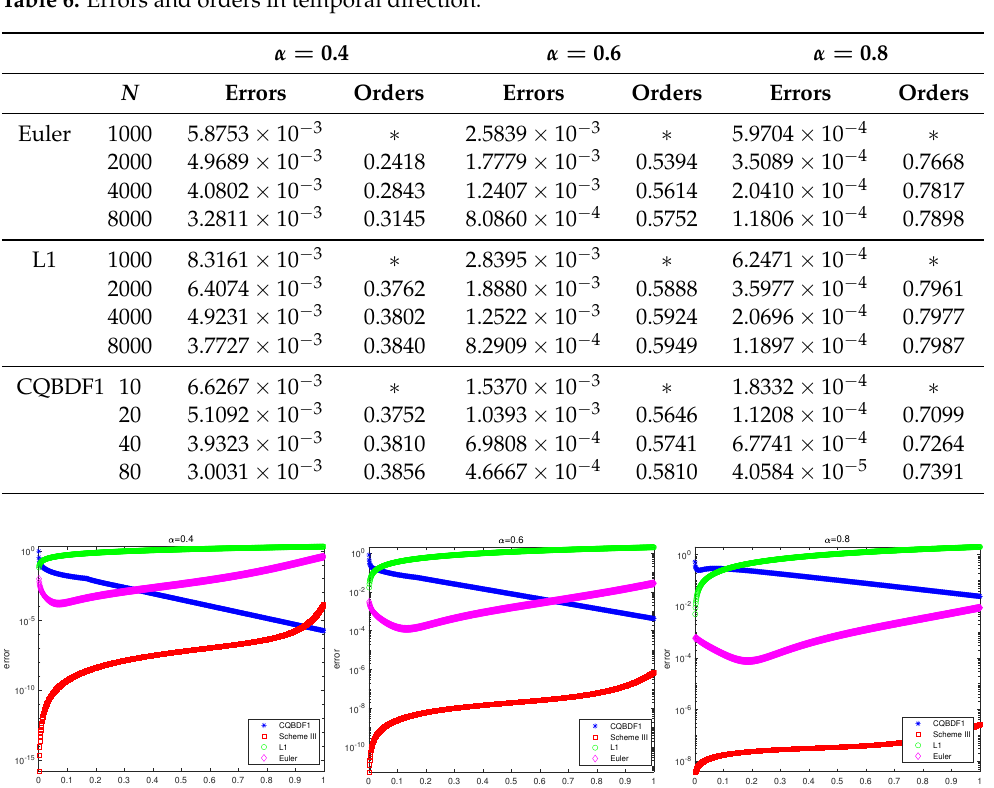
Table 6. Errors and orders in temporal direction.